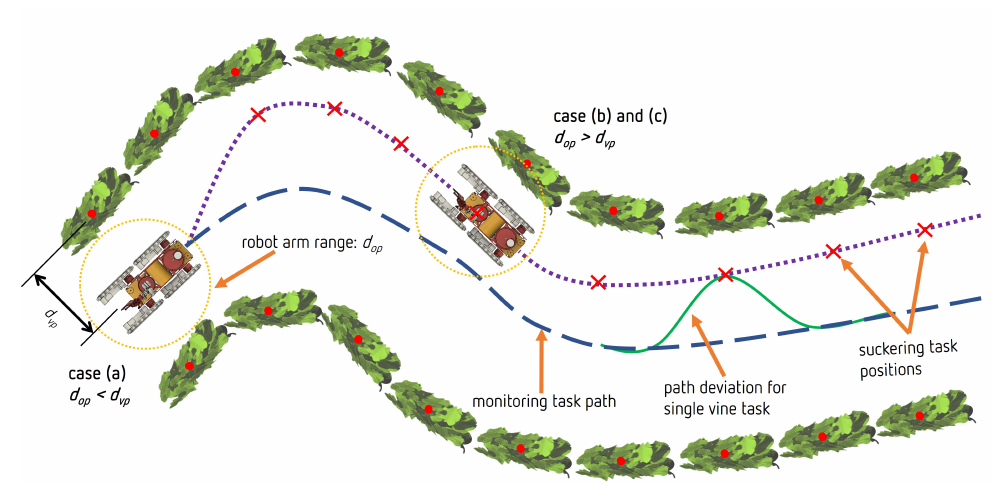
Figure 6. Schematic overview of the three possible cases of the navigation process with positions of ATMM-VIV, in relation to the vine trunks in the aisle. The positions of the vine trunks are marked with a red dot. In case (a), the robot navigates through the center of the aisle. This case is suitable for a surveillance task. In case (b), the robot navigates continuously near the vines, which is required for the spraying task. In case (c), the robot also navigates from point to point (marked with red cross) in the immediate vicinity of the vines to ensure that the trunk of the vines is within the working range of the robot arm, which is a necessary condition for the suckering task.